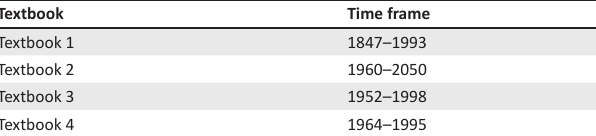
TABLE 2: Time frames for post-colonial Africa from the four textbooks (visual